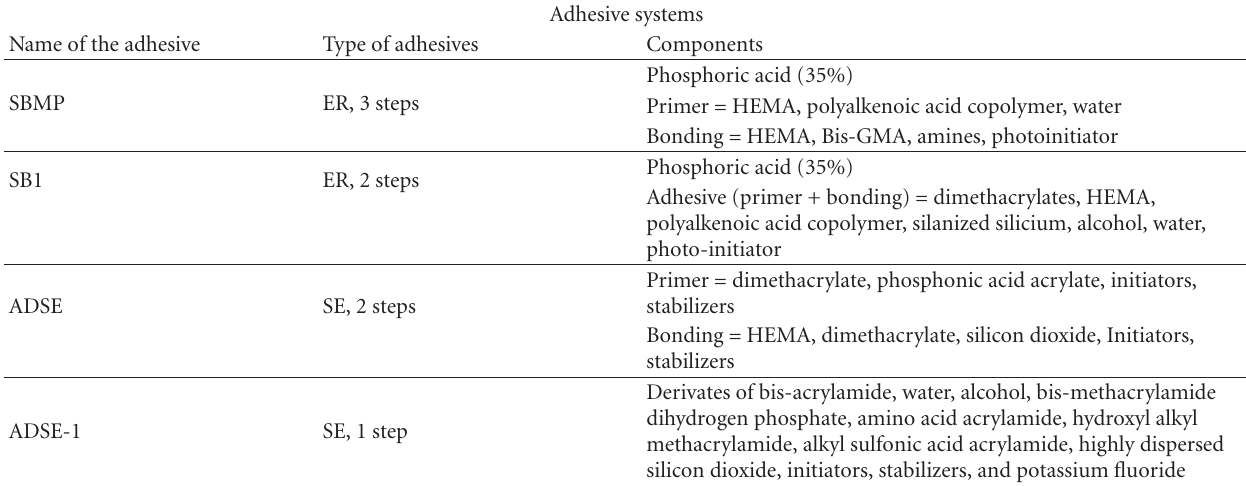
Table 1: The di ff erent tested adhesive systems and their